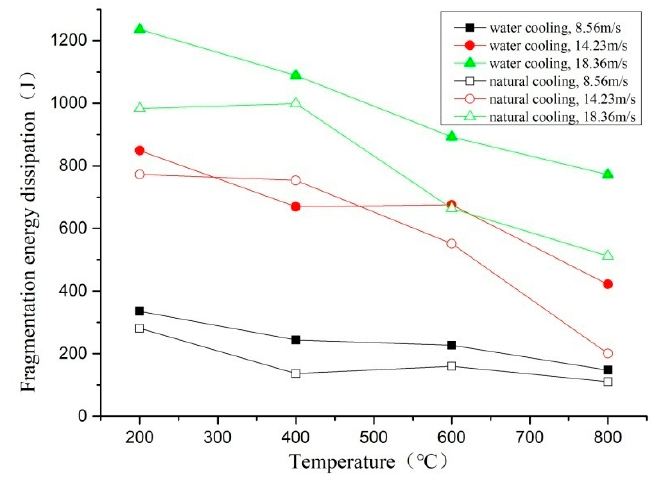
Figure 16. Fragmentation energy dissipation of different cooling methods.